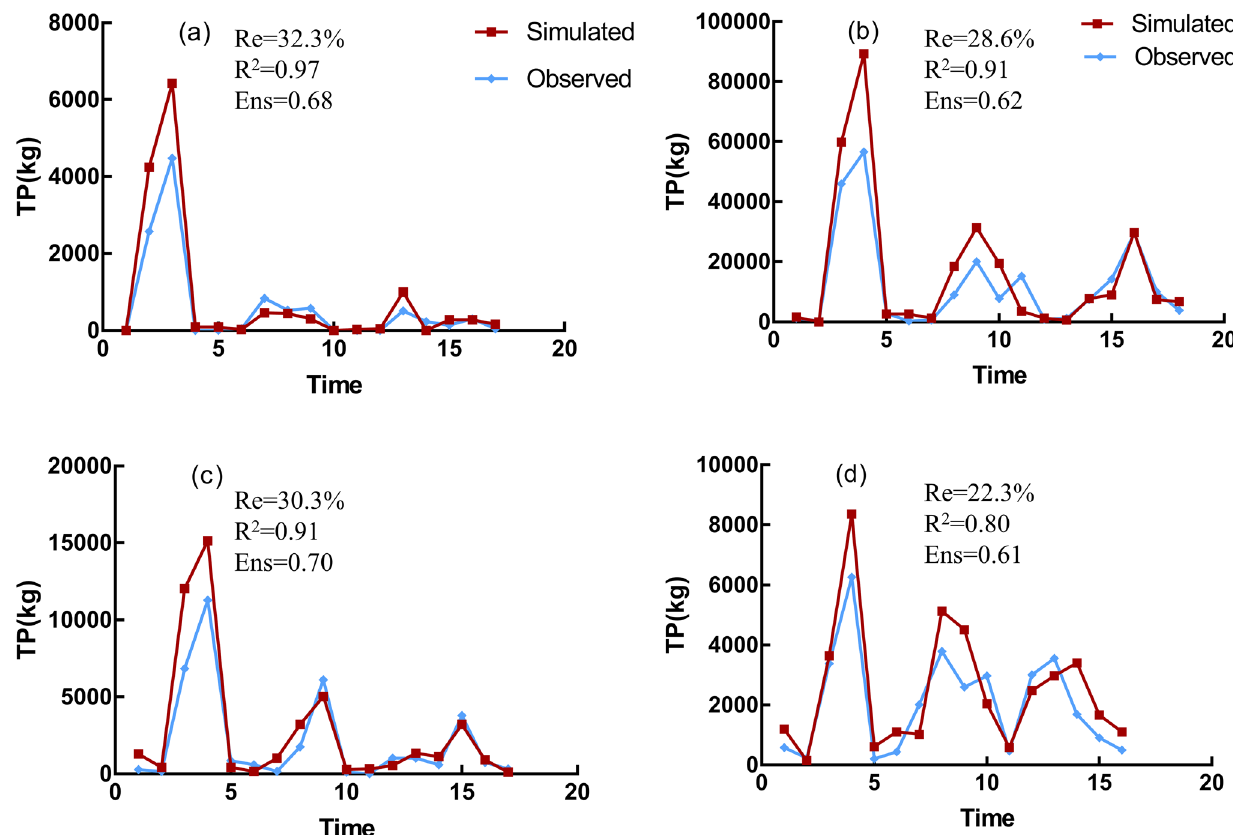
Fig. 5 Comparison of observed and simulated monthly TP during calibration period at different stations: a Dongdingjia; b Zaochao; c Houlugezhuang; d